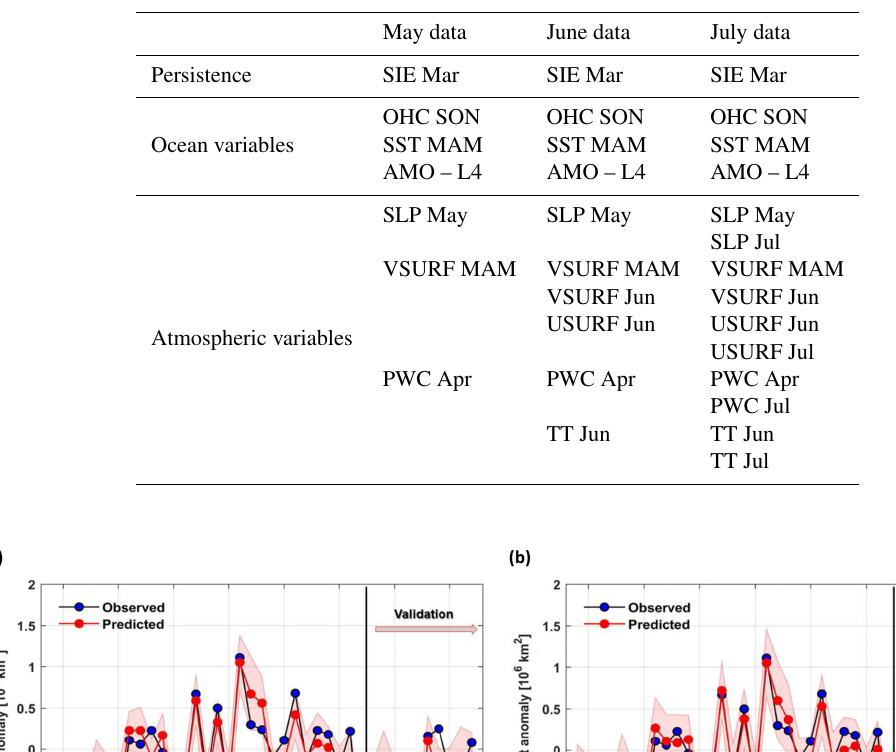
Table 3. Variables retained for the September pan-Arctic sea ice extent forecast (black boxes in Figs. 1–3). Single months are abbreviated with the first three letters of the month.